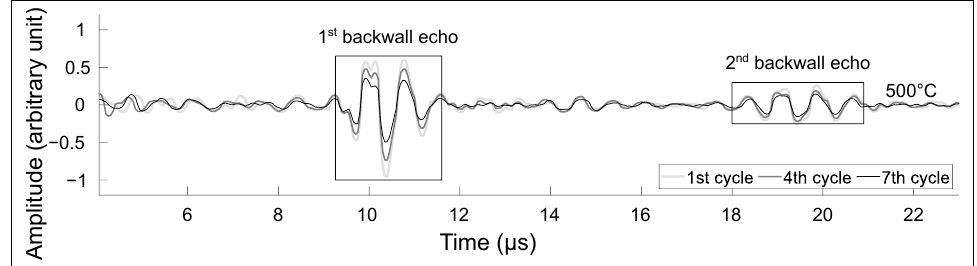
Figure 9. Signals obtained at three different stages of the thermal cycling experiment. The signals shown were obtained after one hour at 550 ◦ C. The thick light grey line was obtained during the first cycle, the dark grey lines during the fourth cycle and the thin black line during the seventh